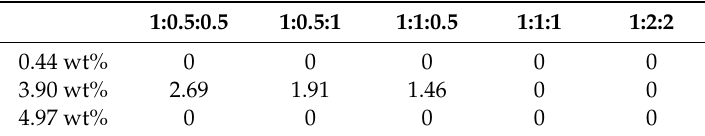
Table 7. Comparison of the maximum molar quantity of C 2 H 4 per unit weight of photocatalyst with illumination time among di ff erent molar ratios of CO 2 / H 2 / H 2 O and Pd loading weight with UV light illumination (unit: µ mol / g).